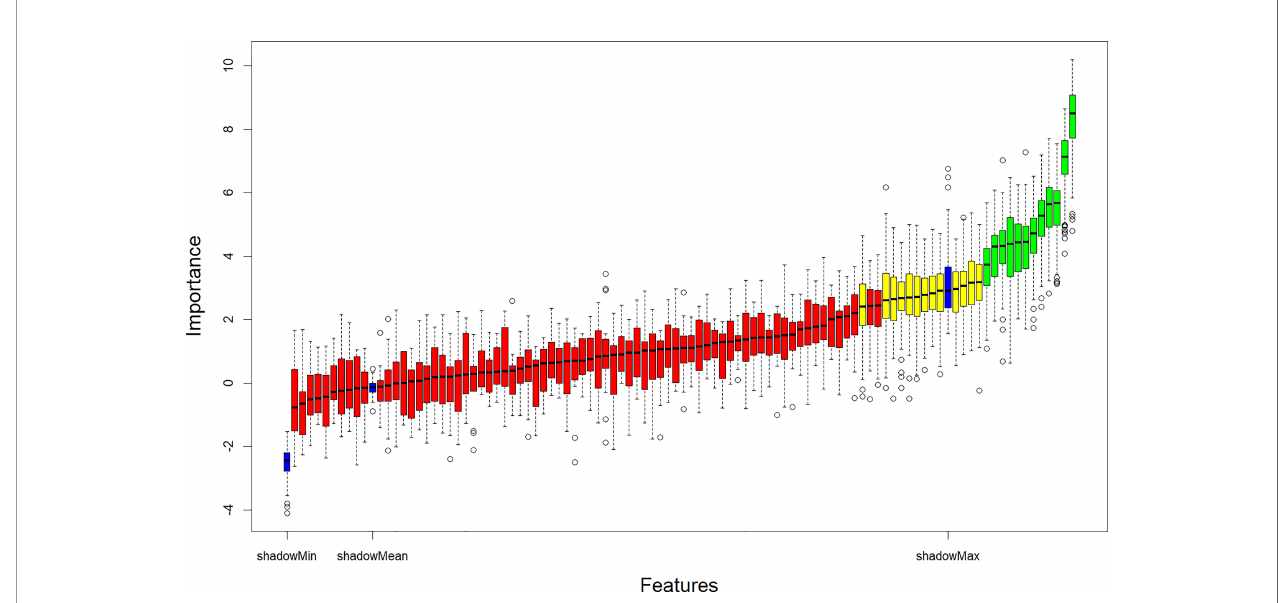
FIGURE 2 | Relevant features (highlighted in green) to the NSCLC subtypes selected with the Boruta algorithm. NSCLC, Non-small cell lung